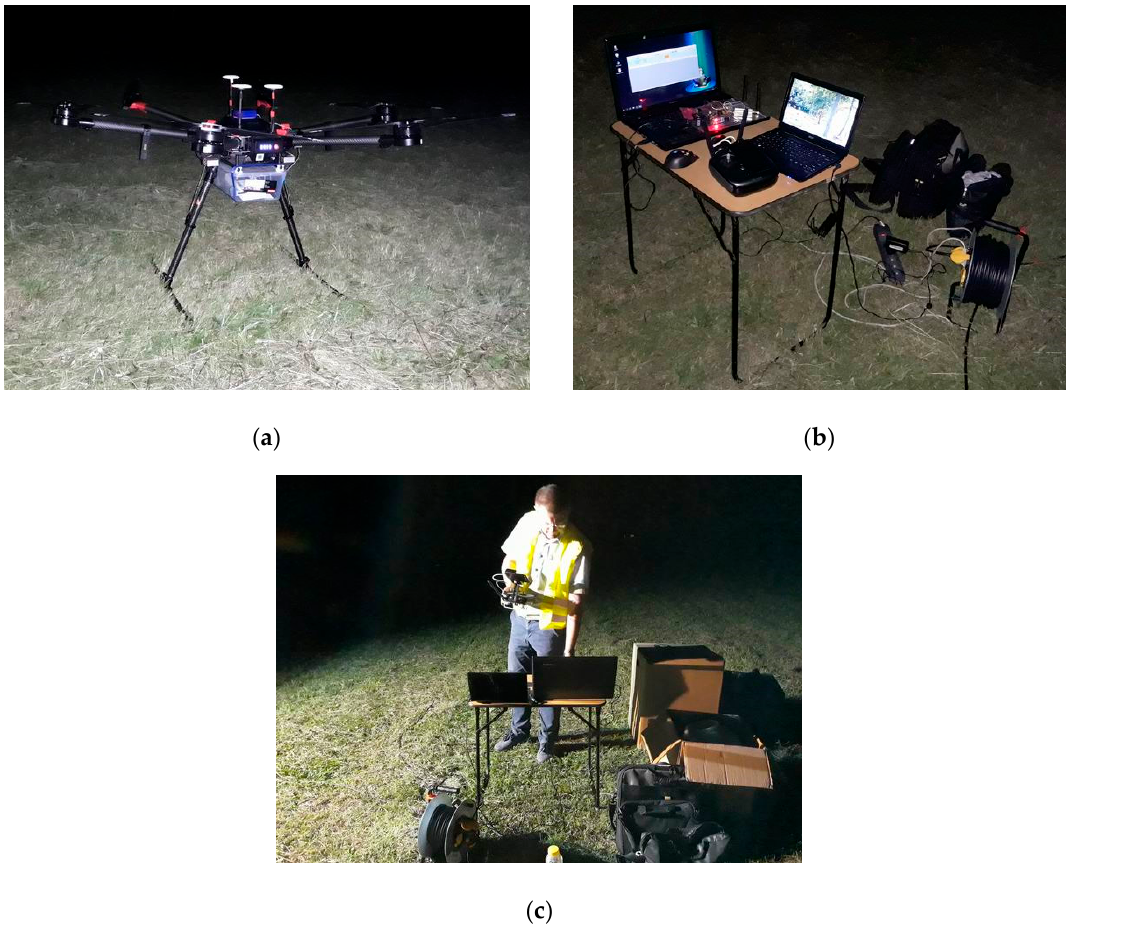
Figure 3. ( a ) Unmanned aerial vehicle (UAV) with a box attached to its construction (block A from Figure 2) equipped with the necessary equipment to make measurements; ( b , c ) drone’s flight control measurement data collection station (blocks B and C from Figure 2).